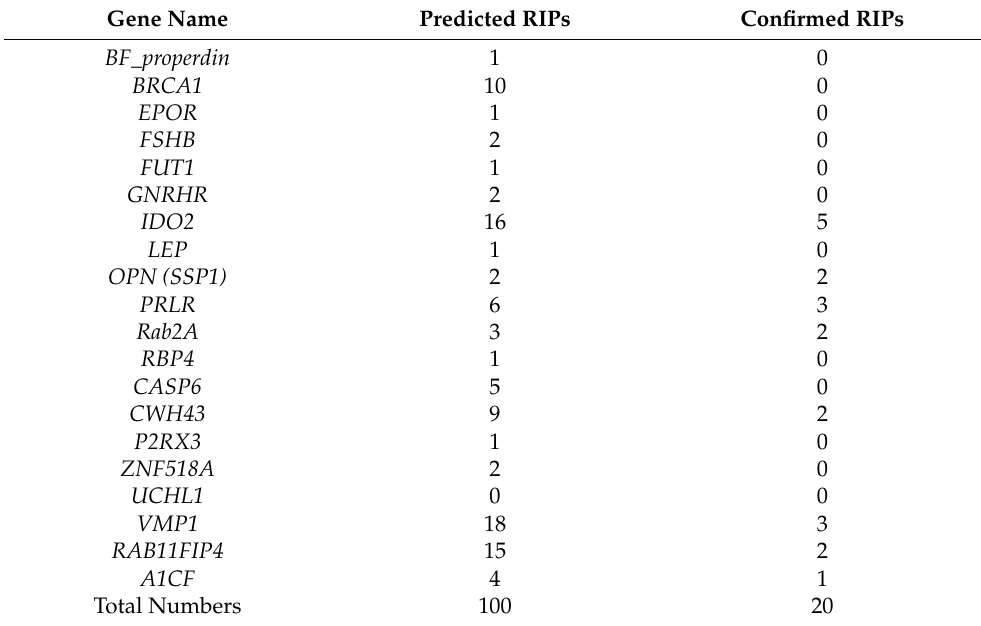
Table 1. The predicted large structural variations (SVs) by alignment in the reproductive related genes and their flanking